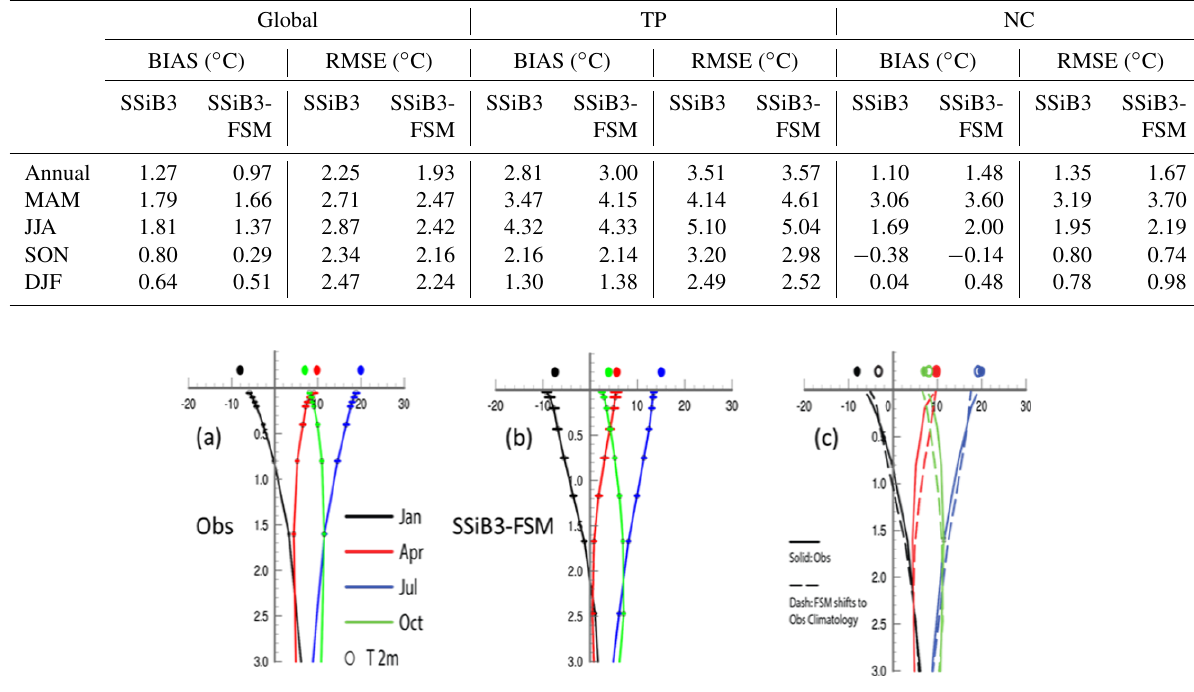
Table 1. Error statistics of the simulated surface temperature by SSiB3-FSM and SSiB3. Global